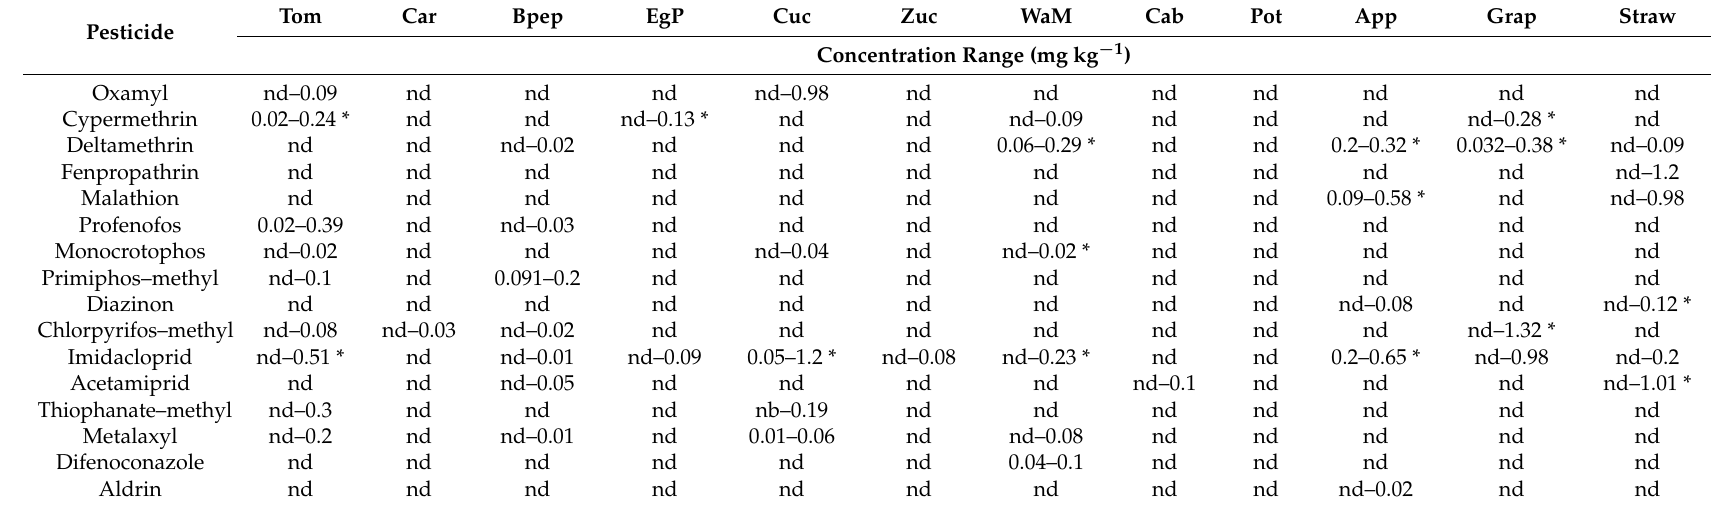
Table 3. Concentration ranges of pesticide residues in fruit and vegetable samples